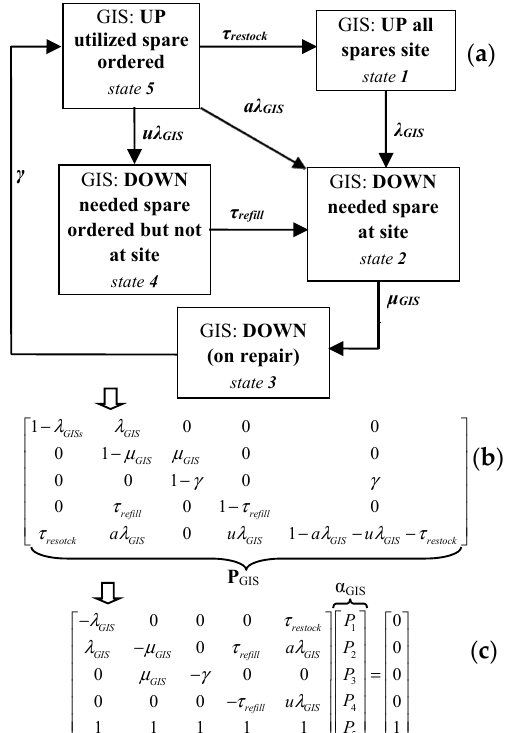
Figure 2. Representation of the GIS sub-system by means of the Markov theory: ( a ) Markov state space diagram of the GIS subsystem; ( b ) stochastic transitional probability matrix; ( c ) matrix representation of the GIS state space diagram.